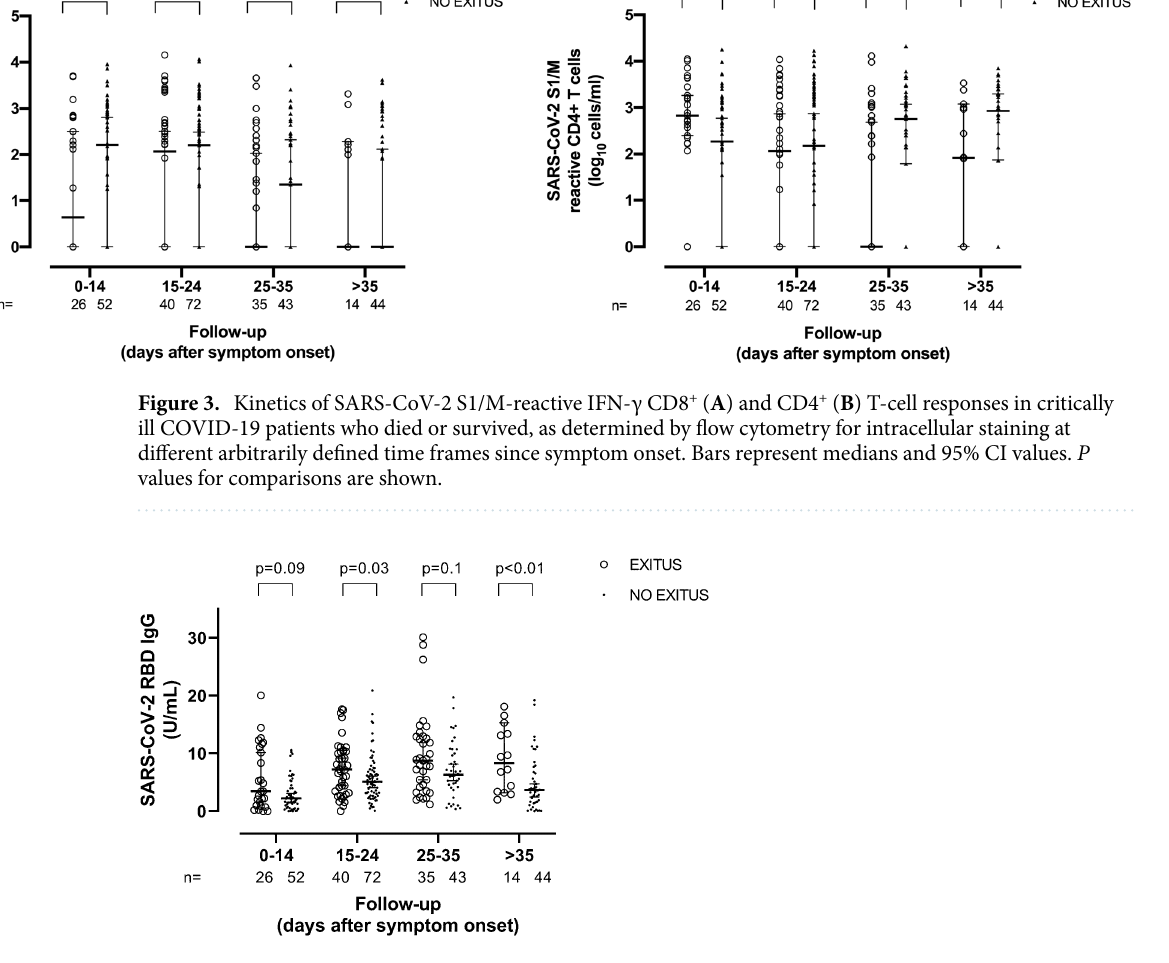
Figure 4. Serum levels of anti-Receptor Binding Domain (RBD) IgG in critically ill COVID-19 patients who died or survived at different arbitrarily defined time frames since symptom onset. Bars represent medians and 95% CI values. P values for comparisons are